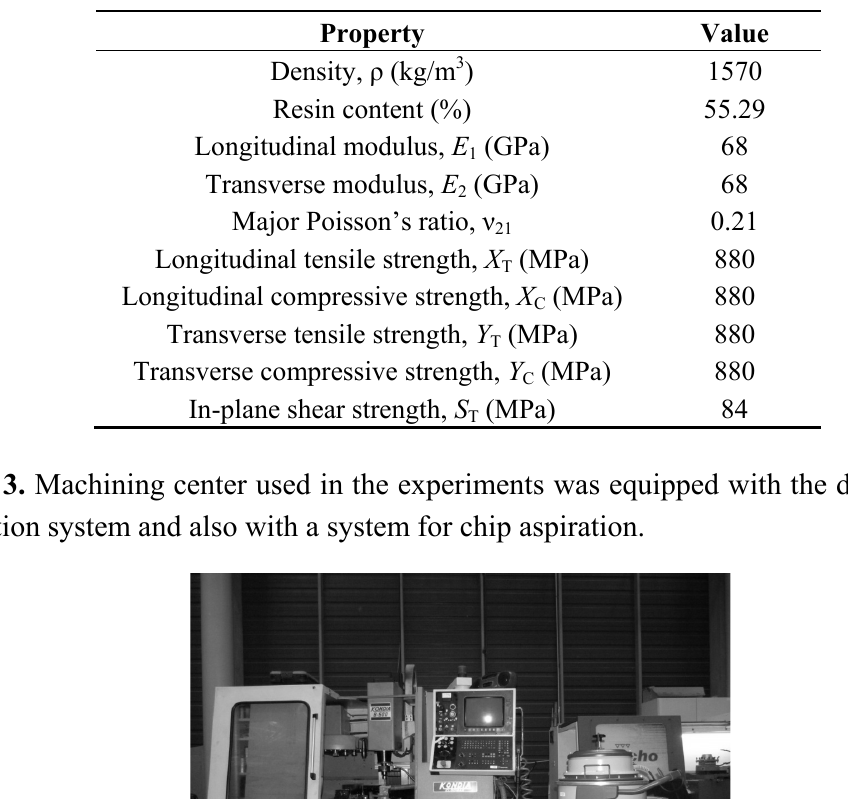
Table 1. Mechanical properties of AGP 193-PW/8552 composite material [24].